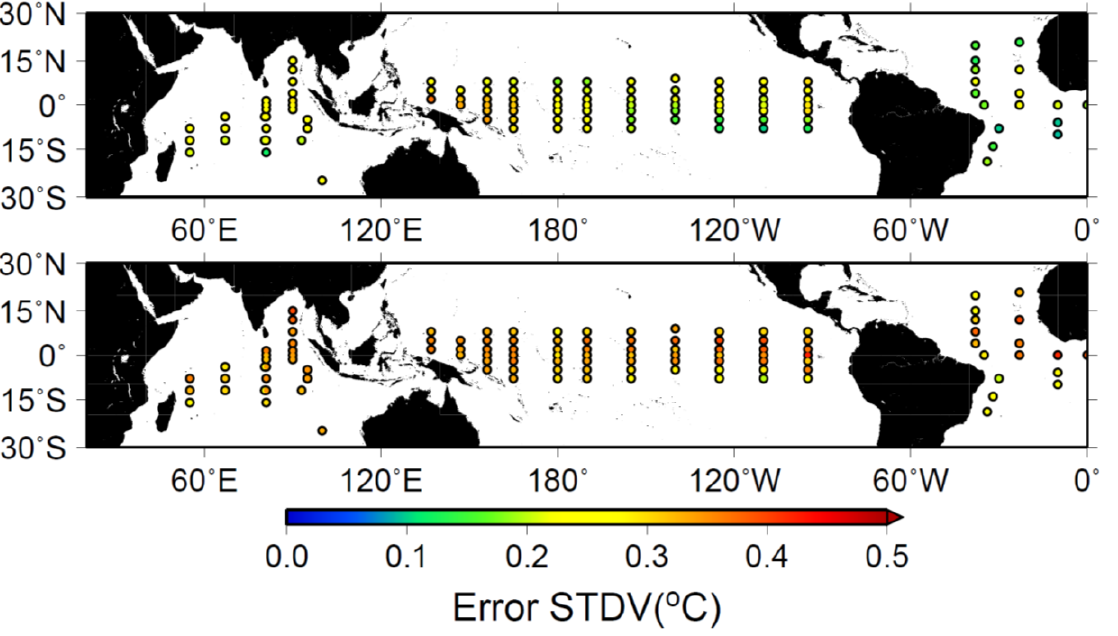
Figure 2. Standard deviation distributions for the daily satellite-based SST estimates against each moored buoy measurement. (Top) diurnal SST range estimates, and (bottom) foundation SST estimations. Geostationary Satellite-Based SST